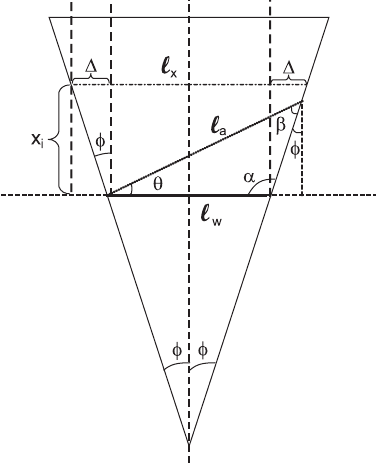
FIG. 16. Geometric schematic of the wedge that illustrates the quantities needed for the proof of